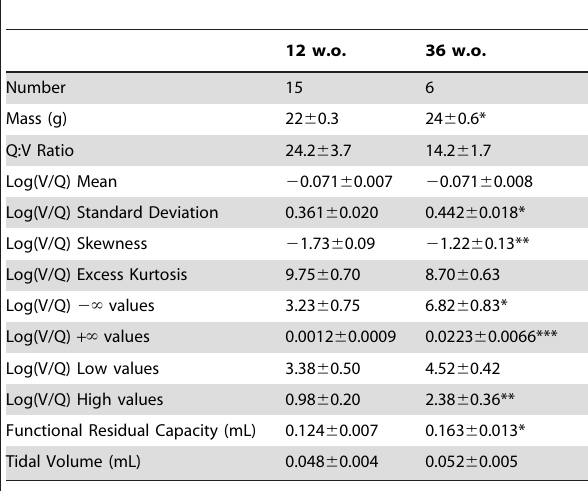
Table 1. Comparison of group characteristics between 12 week old and 36 week old